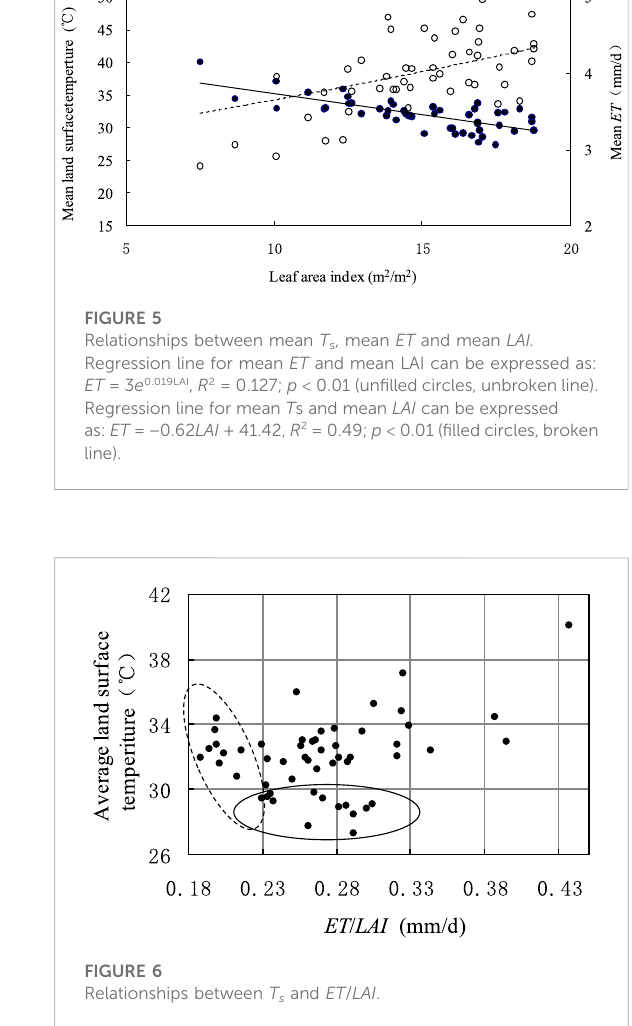
FIGURE 6 Relationships between T s and ET / LAI